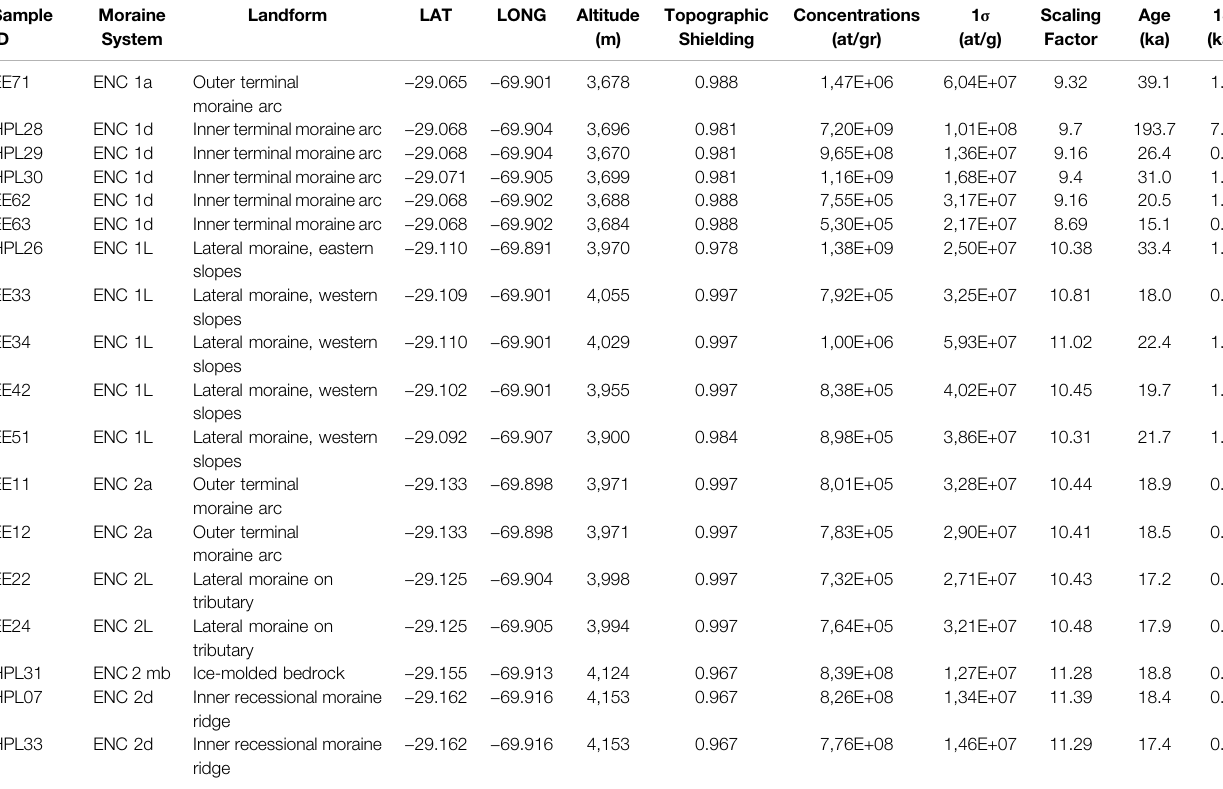
TABLE 1| Sample information, the measured 10 Be concentrationsin quartz and calculated 10 Be exposureage of this work(HPL) and recalculated from Zech et al. (2006) in the Encierro Valley (EE). A density of 2.7 g/cm 3 was considered for quartz. Detailed analytic results in supplementary digital materials. Sample